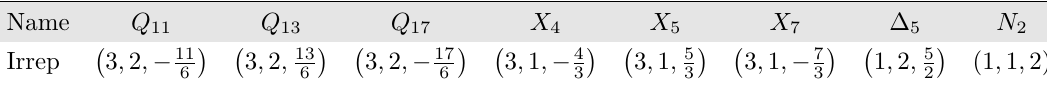
Table 5. New vector-like fermions.